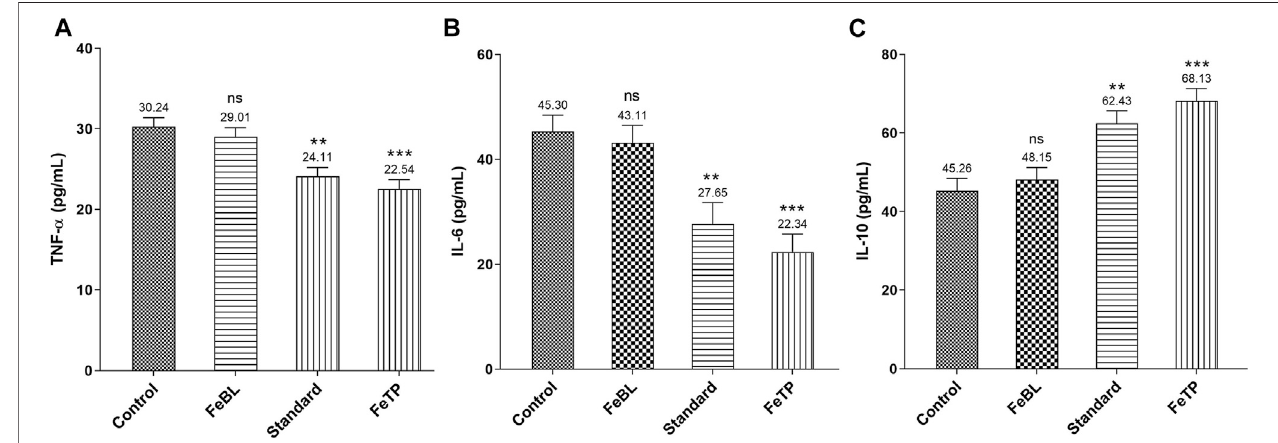
FIGURE 6 | Effect of FeTP on in fl ammatory markers in granulation tissue by estimation of (A) TNF- α level, (B) IL-6 level, and (C) IL-10 level. Data represented as mean ± SEM, analyzed by one-way ANOVA followed by Dunnett ’ s test. Mean values are shown above bar and error bar. Signi fi cant difference ** p < 0.01, *** p < 0.001, and ns, non-signi fi cant in comparison to control group.